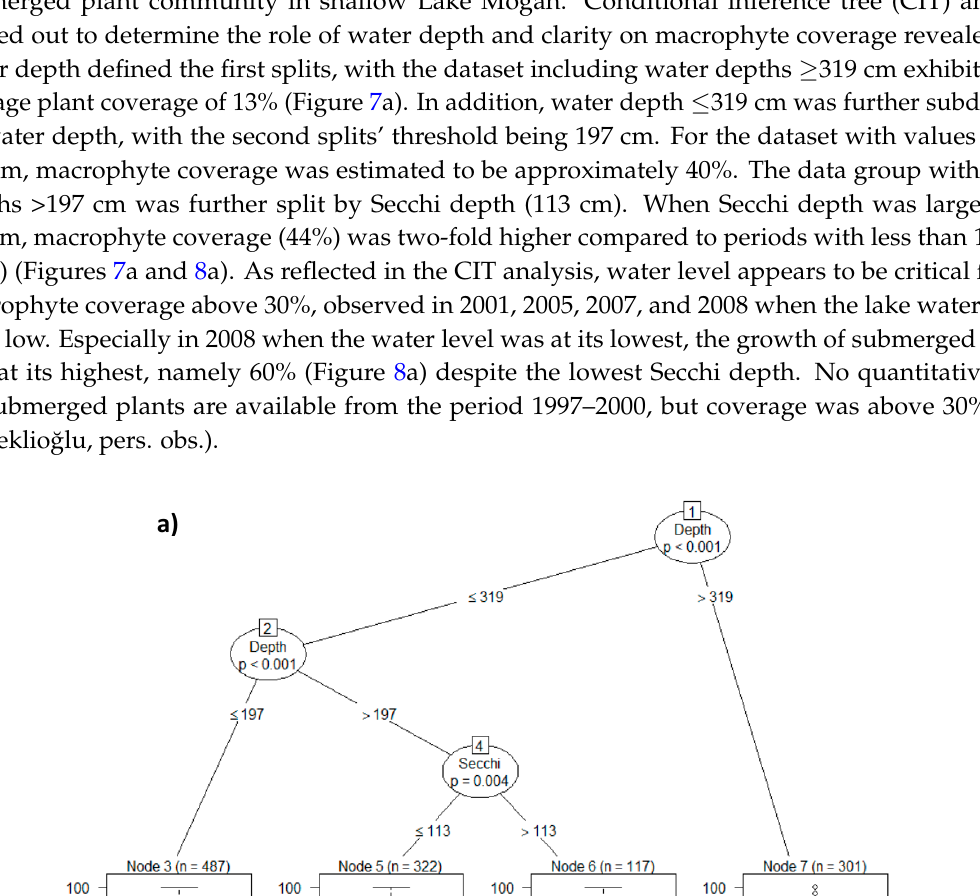
Figure 7. Conditional Inference Trees for ( a ) Lake Mogan and ( b ) Lake Eymir (Depth: water depth, Secchi : Secchi depth, n: number of sampling points, mean: mean macrophyte coverage). The data in the figure represent plant coverage and Secchi depth values measured at each transect point during the plant surveys each year.